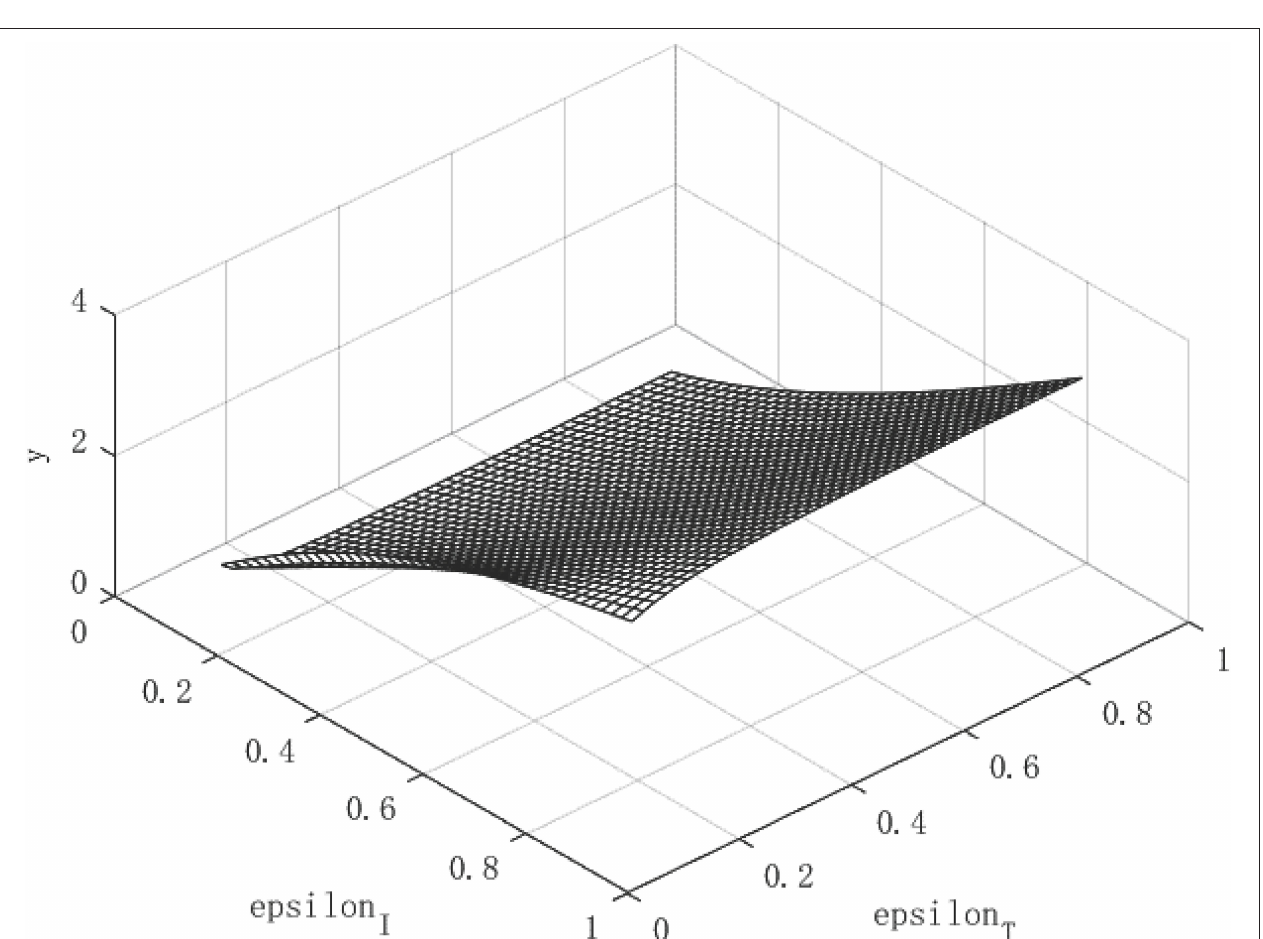
FIGURE 6 | Growth path of per capita output under low contagious public health emergencies.